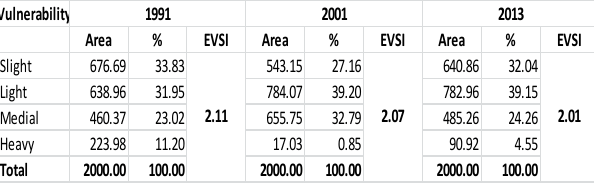
Table 4. Computed results from formula 3 and percentage area of each vulnerability level.